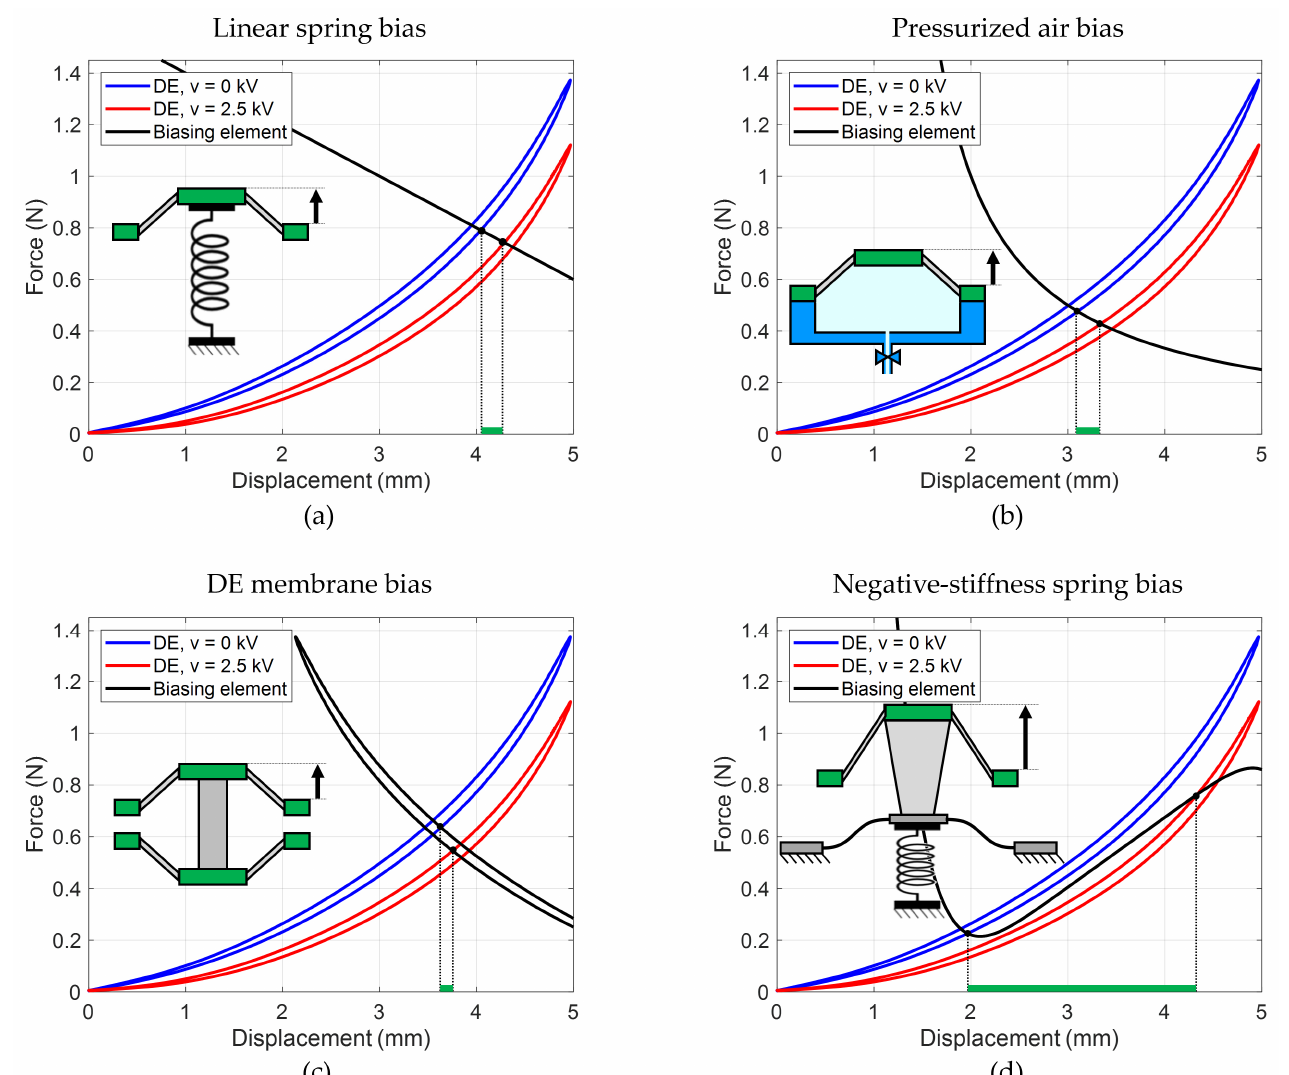
Figure 4. Examples of biasing elements used in membrane DEAs: linear spring ( a ), pressurized air ( b ), a second DE membrane ( c ), and negative-stiffness spring ( d ). In each case, the green segment quantifies the resulting actuation stroke.